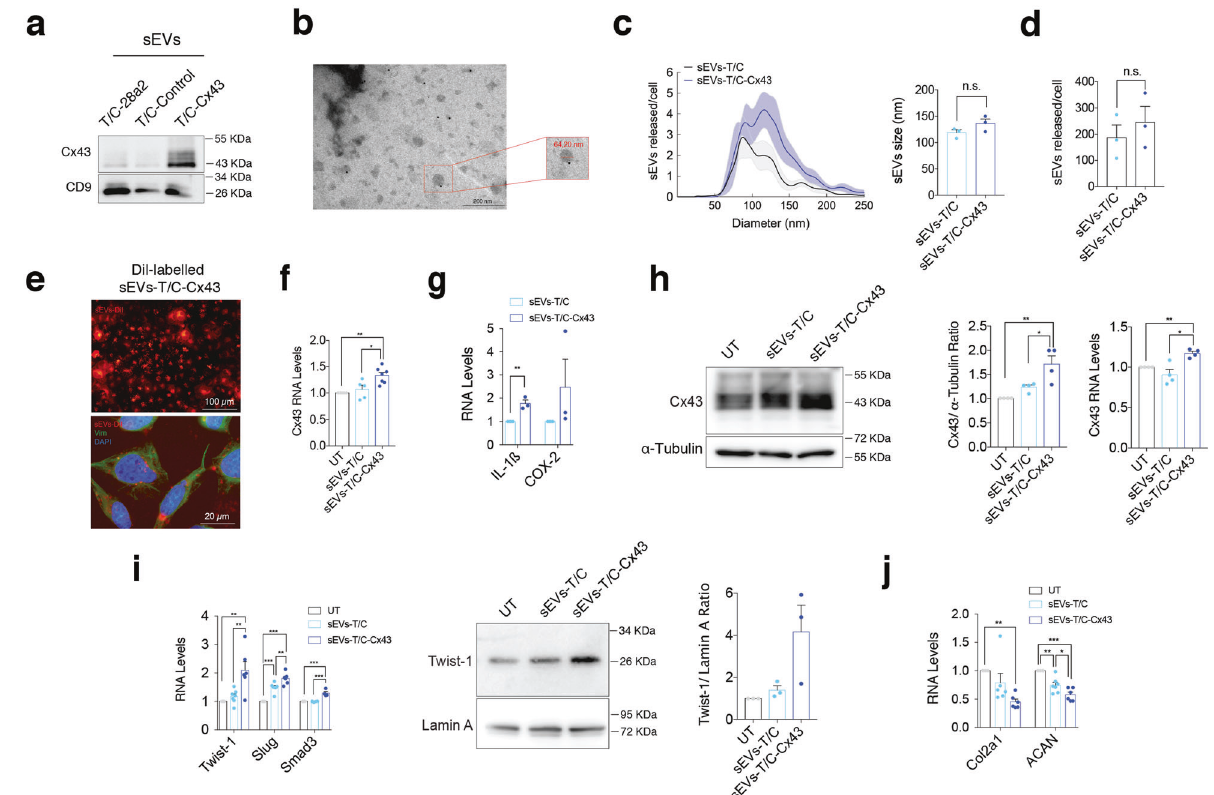
Fig. 3 sEVs derived from human osteoarthritic chondrocytes promote OA-phenotype in target chondrocytes. a The human chondrocyte cell line T/C-28a2 overexpressing Cx43 released sEVs with higher Cx43 content as detected by WB. b Representative electron microscopy image of CD9-immunogold labelling from sEVs released by Cx43-overexpressing T/C-28a2 cells. c NTA analysis showing the average size of sEVs (in nm) derived from T/C-28a2 chondrocytes (sEVs-T/C) and Cx43-overexpressing T/C-28a2 chondrocytes (sEVS-T/C-Cx43), collected after 72 h. n = 3, Student ’ s t test. d NTA analysis of the number of sEVs released by Cx43-overexpressing T/C-28a2 cells and compared to non- transfected T/C-28a2 cells sEVs. n = 3, Student ’ s t test. e Red Dil-labelled sEVs isolated from Cx43-overexrpessing T/C-28a2 cells were detected in T/C-28a2 chondrocytes after 48-h treatment. Co-staining with vimentin antibody (green) and DAPI (blue) were performed to visualize the target cells. f Treatment of T/C-28a2 cells with high-Cx43 sEVs (sEVs-T/C-Cx43) for 48 h promoted Cx43 gene overexpression in target cells ( n = 5 – 7, one-way ANOVA), as well as the expression of the in fl ammatory genes IL-1 β and COX-2 ( n = 3, Student ’ s t test) ( g ). h Treatment of T/ C-28a2 cells with sEVs derived from Cx43-overexpressing T/C-28a2 chondrocytes (sEVs-T/C-Cx43) for 48 h increased both protein and gene expression levels in target chondrocytes. n = 4, one-way ANOVA. i When OA-derived chondrocytes were treated with sEVs-T/C-Cx43 for 48 h, EMT-markers gene ( n = 5 – 7) and protein ( n = 3) expression was upregulated, together with decreased gene expression levels of Col2A1 and ACAN ( j , n = 6); one-way ANOVA. Data are expressed as mean ± S.E.M., * P < 0.05, ** P < 0.01, *** P <